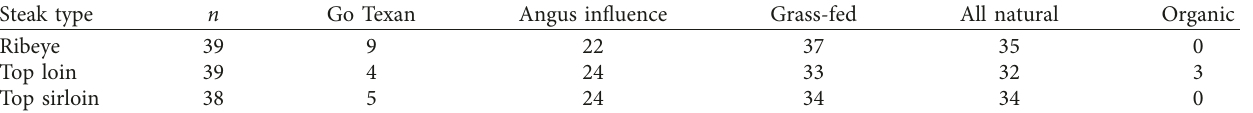
Table 9: Distribution of steaks across marketing and branding claims for Farmers Market